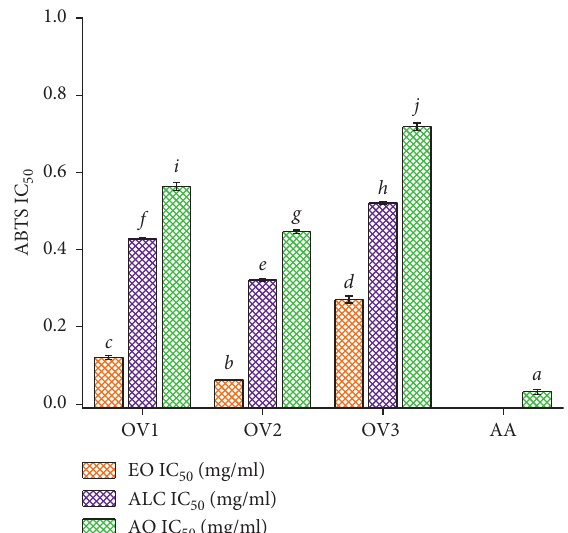
Figure 6: IC 50 plot of ABTS radical scavenging activity of essential oil (EO) and alcoholic (ALC) and aqueous (AQ) extracts of Origanum vulgare from different locations, i.e., Auli (OV1), Pithoragarh (OV2), and Haldwani (OV3).